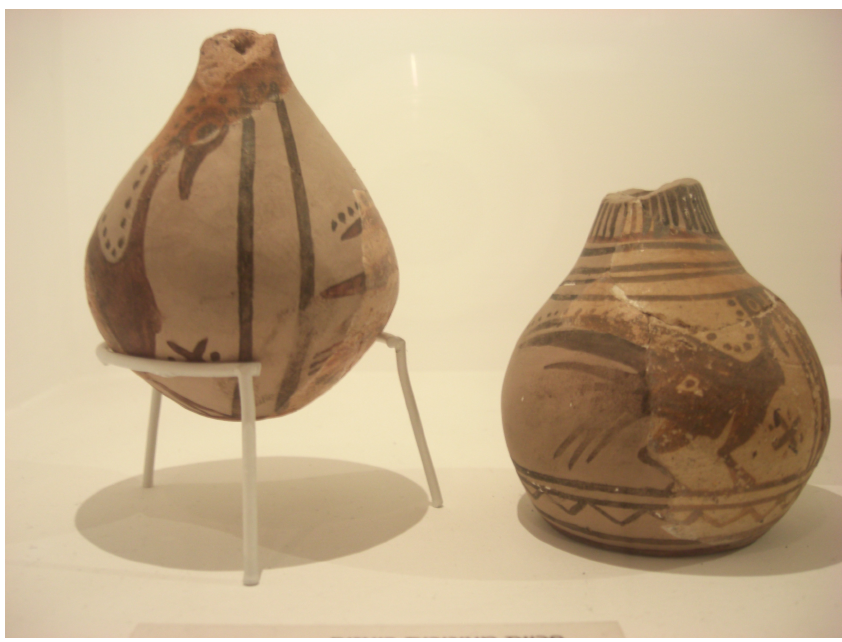
Figure 8 Painted depictions of ostriches in the QPW. From the Temple of Hathor, Timna, Eretz Israel Museum, Tel Aviv. Photo by the author, with kind permission from the Israel Antiquities